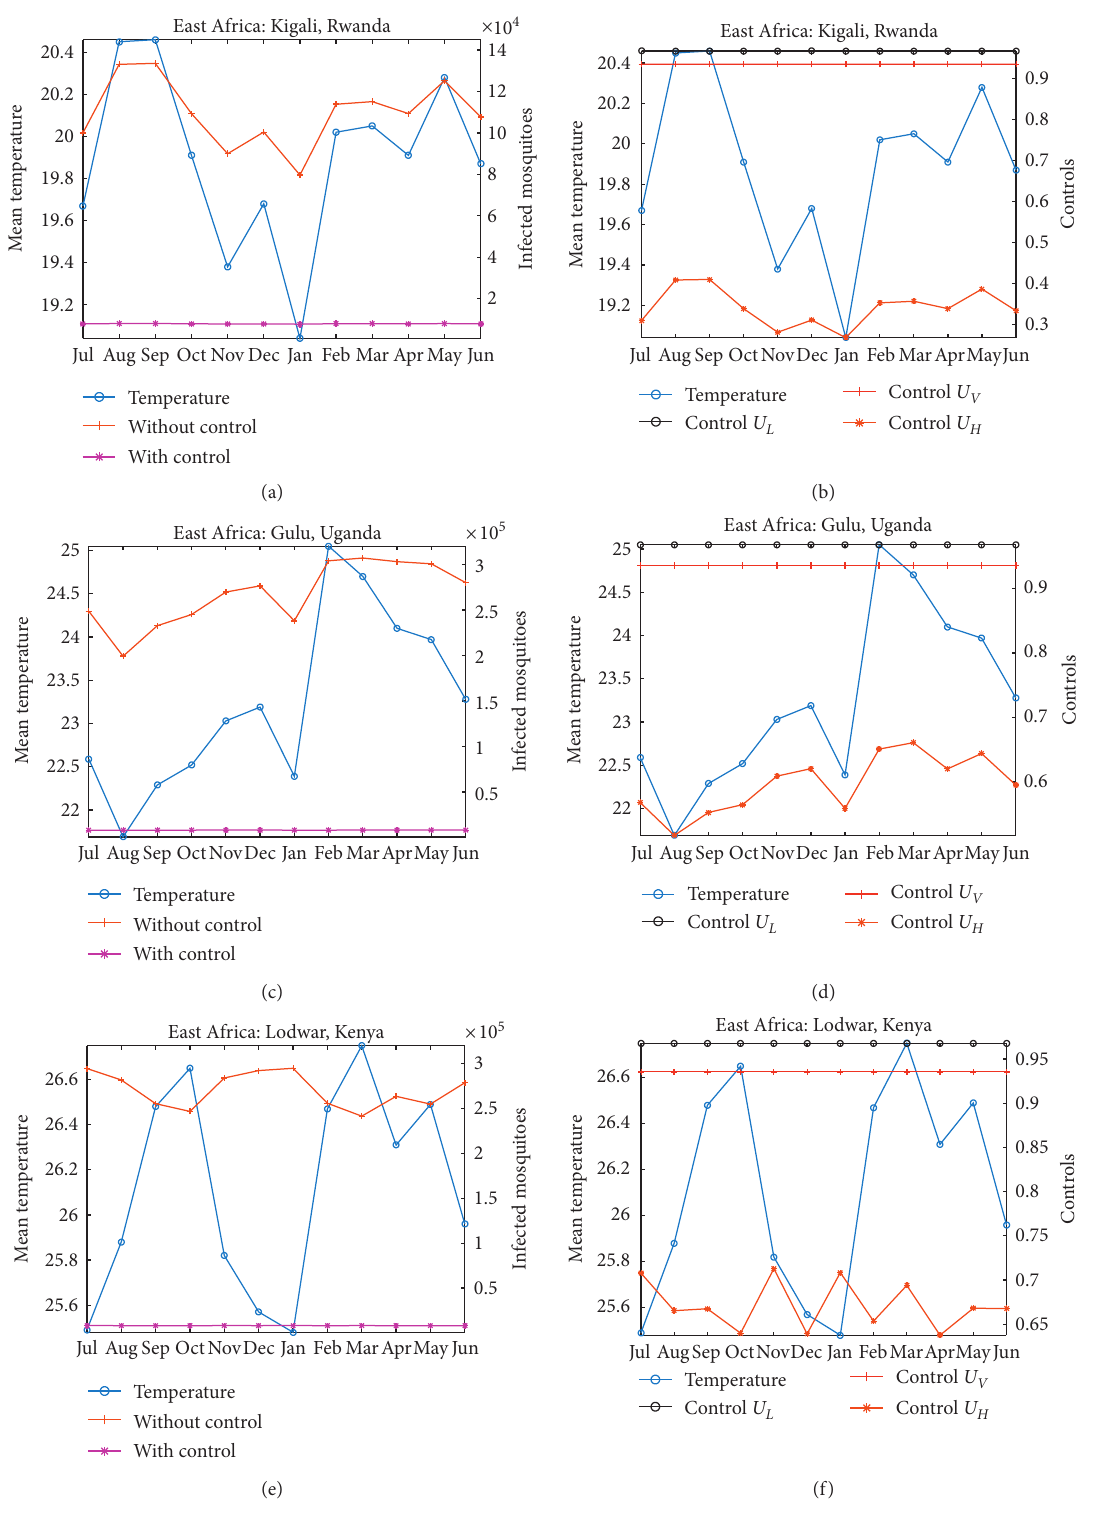
Figure 10: Simulations of the model (2) as a function of time: (a, c, e) the monthly total number of infected mosquitoes without and with control and (b, d, f) optimal controls u H ( t ) ,u L ( t ) , and u V ( t ) , in Kigali, Rwanda; Gulu, Uganda; and Lodwar, Kenya; in East Africa. The mean monthly temperature is plotted in blue lines and is superimposed onto each